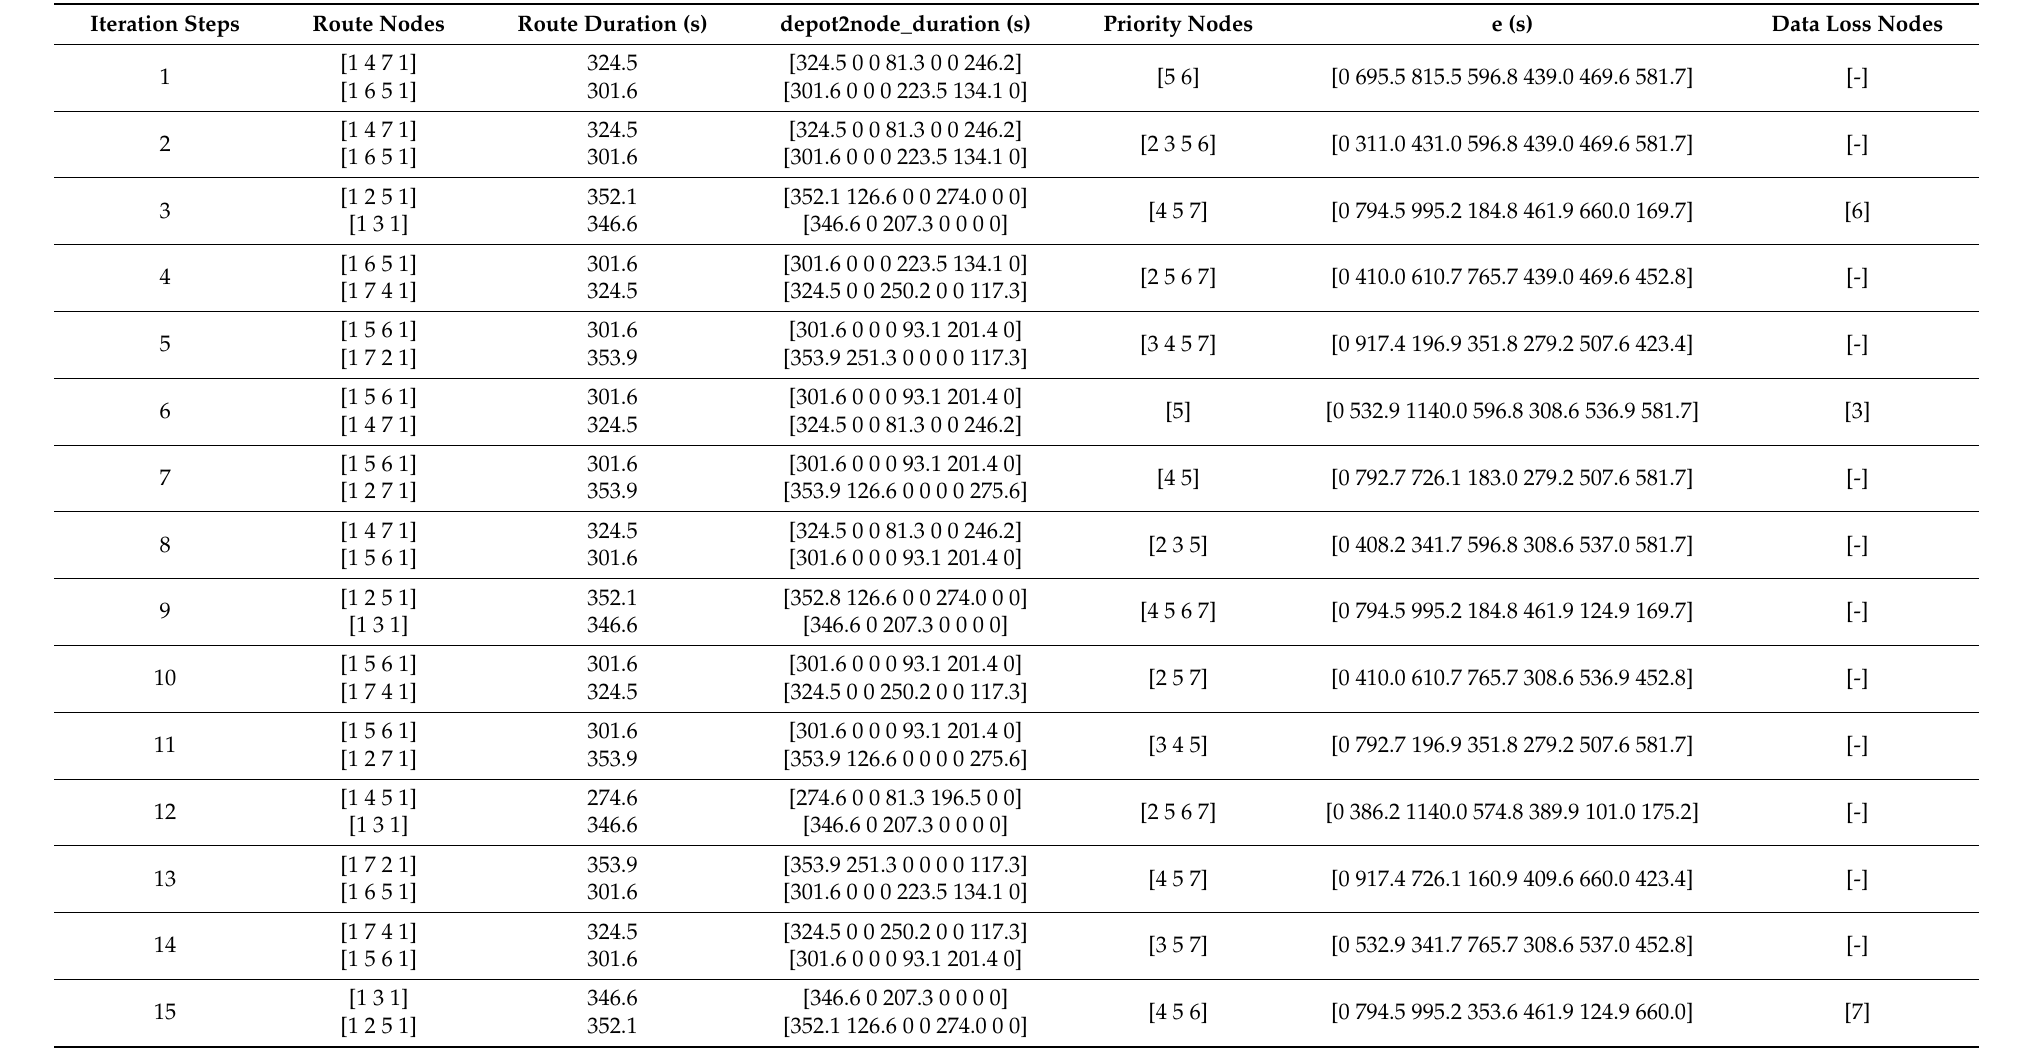
Table 1. MES Routes Results for 7 Static Nodes and 2